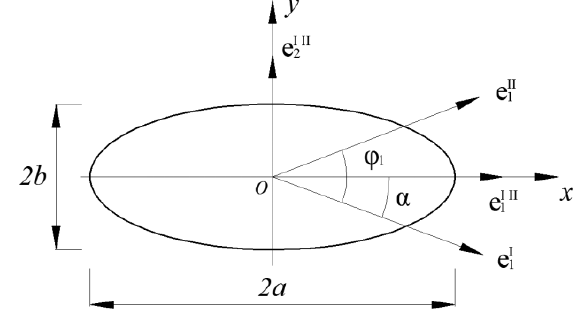
Figure 3. Curvature relationship of the contact tooth surface.